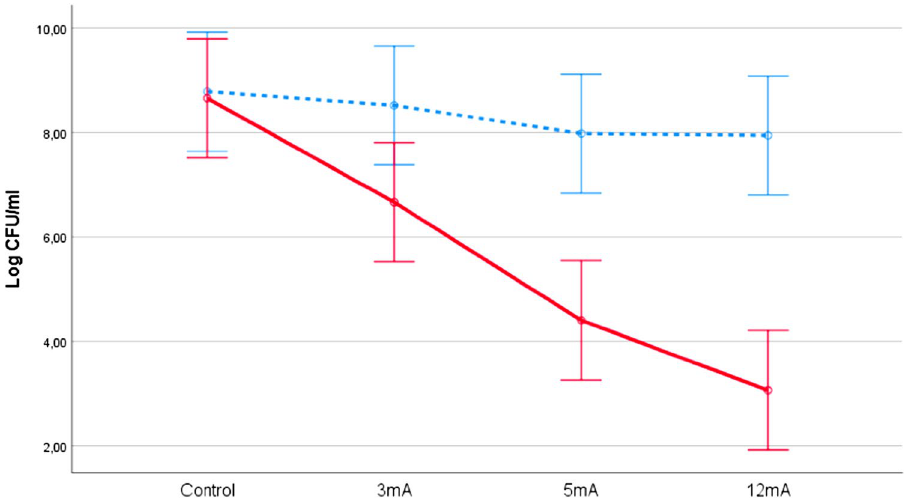
Figure 3. Effect of different doses of galvanic current on a 9 Log 10 CFU/mL concentration of S. aureus in TSB (blue) and saline solution (red). All the doses were applied during 5 s and repeated 5 times. The error bars represent CI (95%).